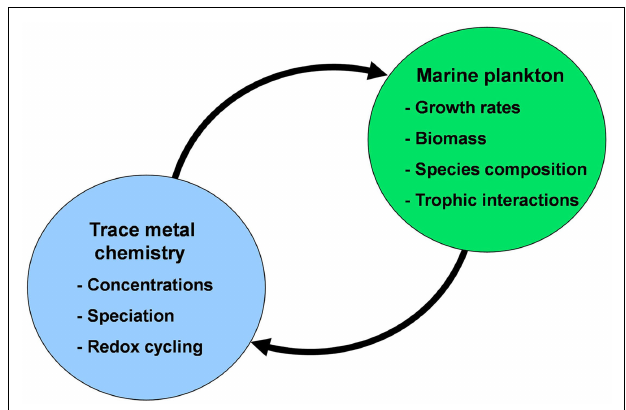
FIGURE 1 | Conceptual diagram of the mutual interactions between trace metal nutrients (Fe, Mn, Zn, Co, Cu, Mo, and Cd) and phytoplankton in the sea. In these interactions the chemistry of trace metal nutrients (their concentrations, chemical speciation, and redox cycling) regulate the productivity, species composition, and trophic interactions of marine phytoplankton communities.These communities in turn regulate the chemistry and cycling of the trace metals through cellular uptake and assimilation, vertical transport of biogenic particles (intact cells and fecal pellets), mediation of metal regeneration processes (by grazers, bacteria, and viruses), production of organic chelators, and biological mediation of metal redox